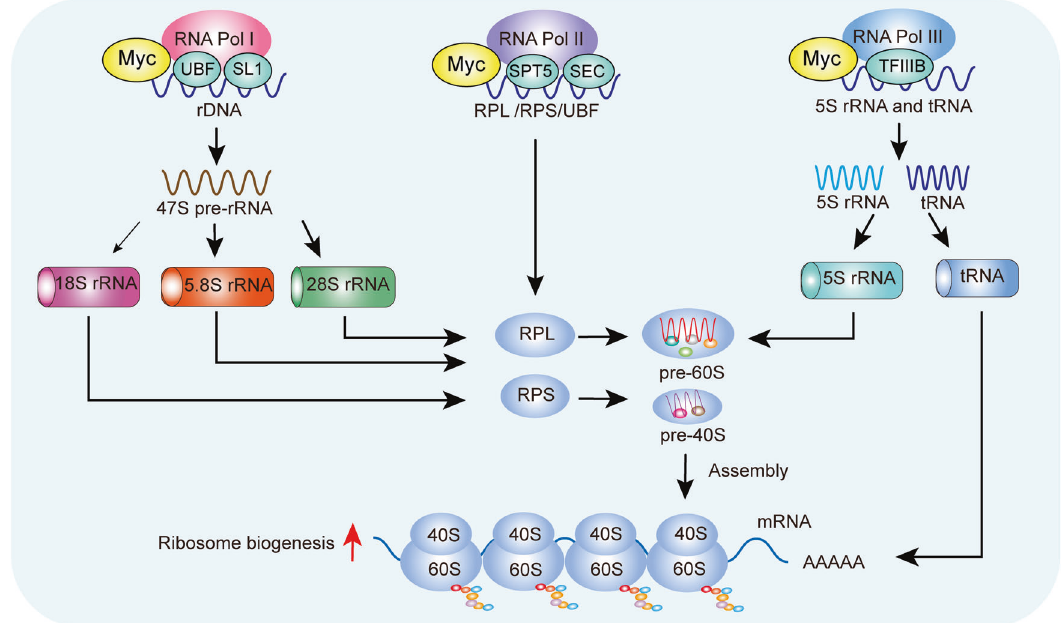
Fig. 3 Myc regulates ribosome biogenesis. Myc directly regulates rRNA processing, ribosome assembly, translocation from the nucleus to the cytoplasm, and the early steps of mRNA translation. Myc upregulates the transcriptional levels of these factors by recruiting cofactors and remodeling chromatin structure. Myc promotes RNA Pol I-mediated rDNA transcription by binding to UBF and SL1. After transcription, the 47S pre-rRNA is processed into mature 5.8S, 18S, and 28S rRNA. The Myc – STP5/SEC complex stimulates rRNA processing and transcription of RPS and RPL for export in an RNA Pol II-dependent manner. Myc binds transcription factor IIIB (TFIIIB) and activates the transcription of 5S rRNA and tRNA mediated by RNA Pol III. Finally, Myc stimulates RP synthesis through these RNA Pol I – III pathways. Myc myelocytomatosis oncogene, SL1 selectivity factor 1, TFIIIB transcription factor IIIB, UBF upstream binding